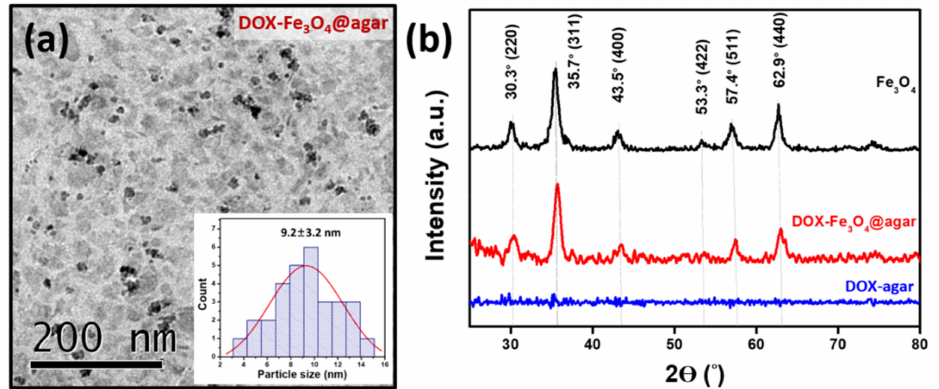
Figure 1. ( a ) TEM image and the inset shows the particle size distribution analysis by TEM image. ( b ) XRD spectrum of Fe 3 O 4 , DOX-agar and DOX-Fe 3 O 4